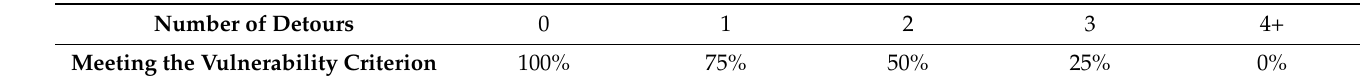
Table 3. Number of Detours.